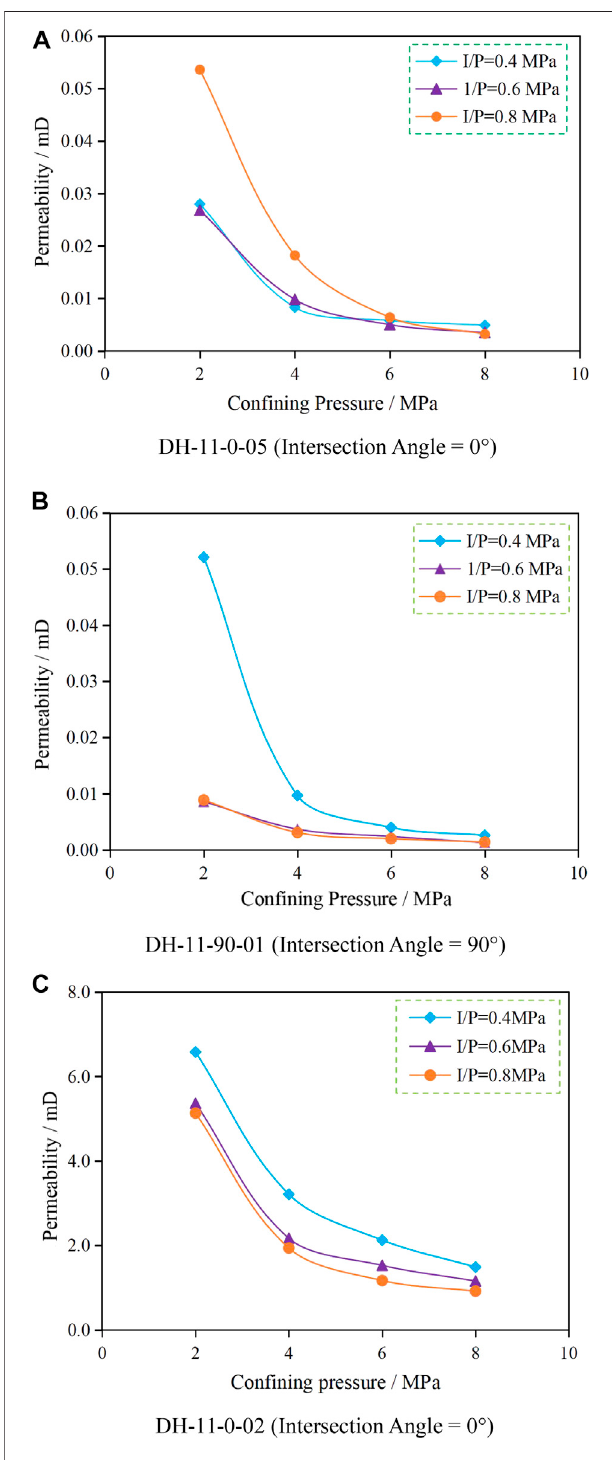
FIGURE 8 | Permeability evolution of DH coal samples under different con fi ning pressures and inlet pressures. (A) DH-11-0-05 (Intersection Angle (cid:2) 0 ° ). (B) DH-11-90-01 (IntersectionAngle (cid:2) 90 (cid:2) ). (C) DH-11-0-02 (Intersection Angle (cid:2) 0 ° ).